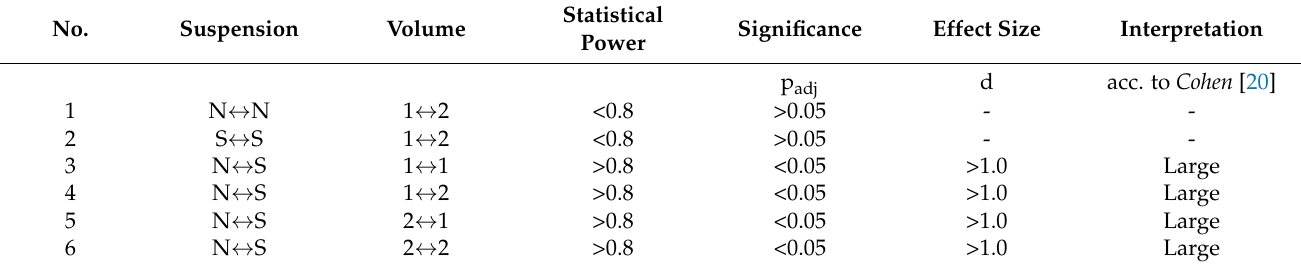
Table 3. Statistical evaluation: Influence of audible impulses on the perception of tactile impulses (N: Normal, S: Sport). No. Suspension